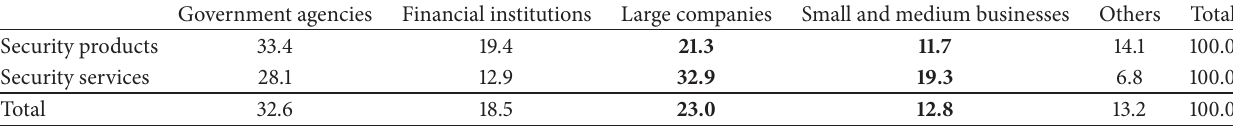
Table 2: Security expenditures (%).